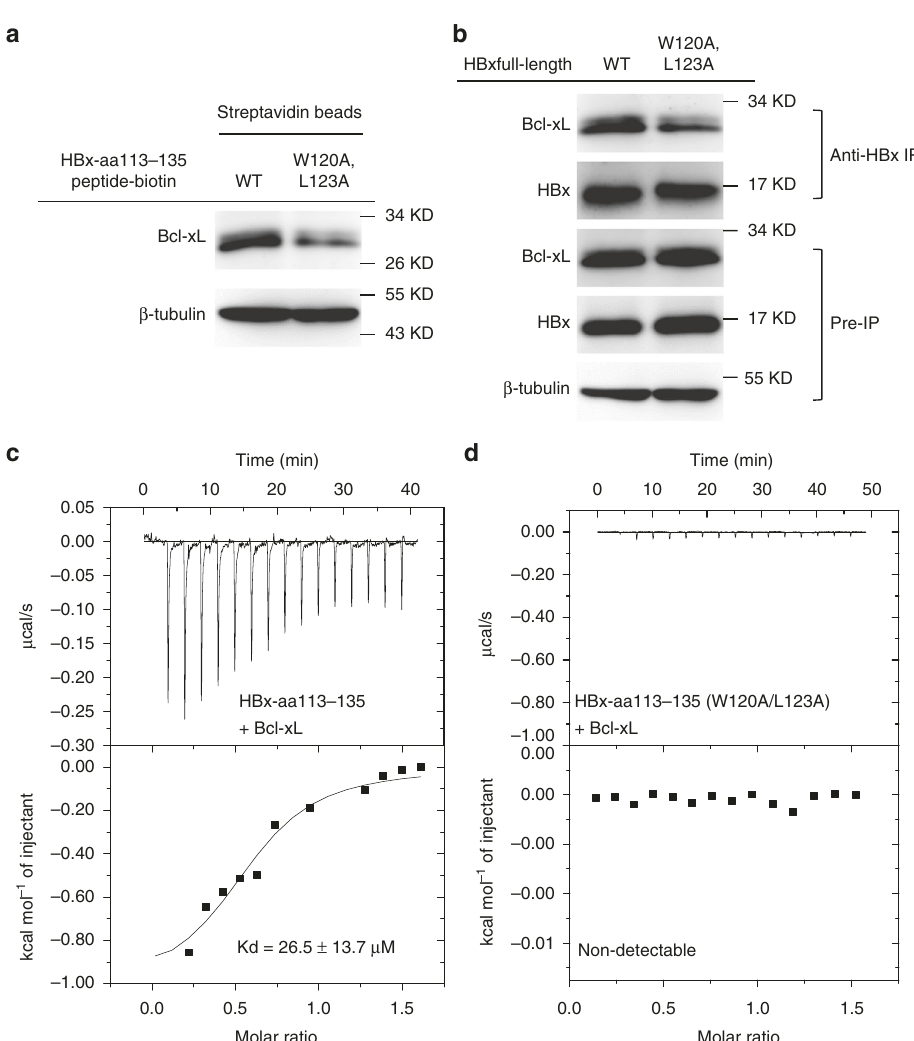
Fig. 2 HBx binds endogenous Bcl-xL through the BH3-like domain. a HBx-aa113 – 135 interacts with Bcl-xL in HepG2 cell lysate. Co-precipitation experiments were performed in the HepG2 cell lysate using biotinylated HBx-aa113 – 135 peptides (wild type (WT)) and corresponding mutant peptides (W120A/ L123A), respectively. The results were analyzed by immunoblotting (IB) using anti-Bcl-xL antibody. β -Tubulin was measured and analyzed as an input control. b Full-length HBx interacts with Bcl-xL in HepG2 cells. Co-immunoprecipitation (co-IP) experiments were performed in HepG2 cells transfected with pTT22m-HBx-WT or pTT22m-HBx(W120A/L123A). The cell lysate was precipitated by an anti-HBx antibody and analyzed by immunoblotting